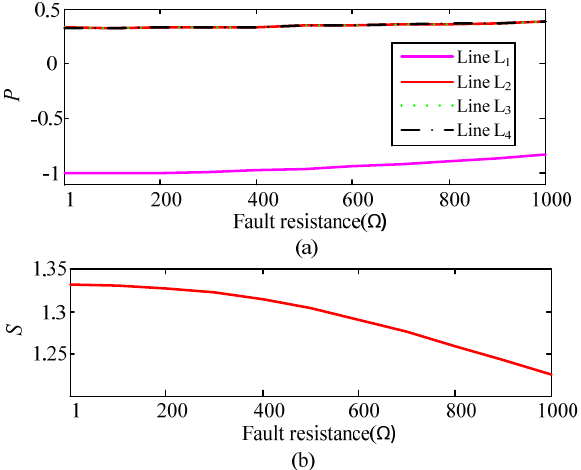
Figure 16. S and P of each feeder for different fault resistances. ( a ) P of each feeder for different fault resistances; ( b ) S of different fault resistances.